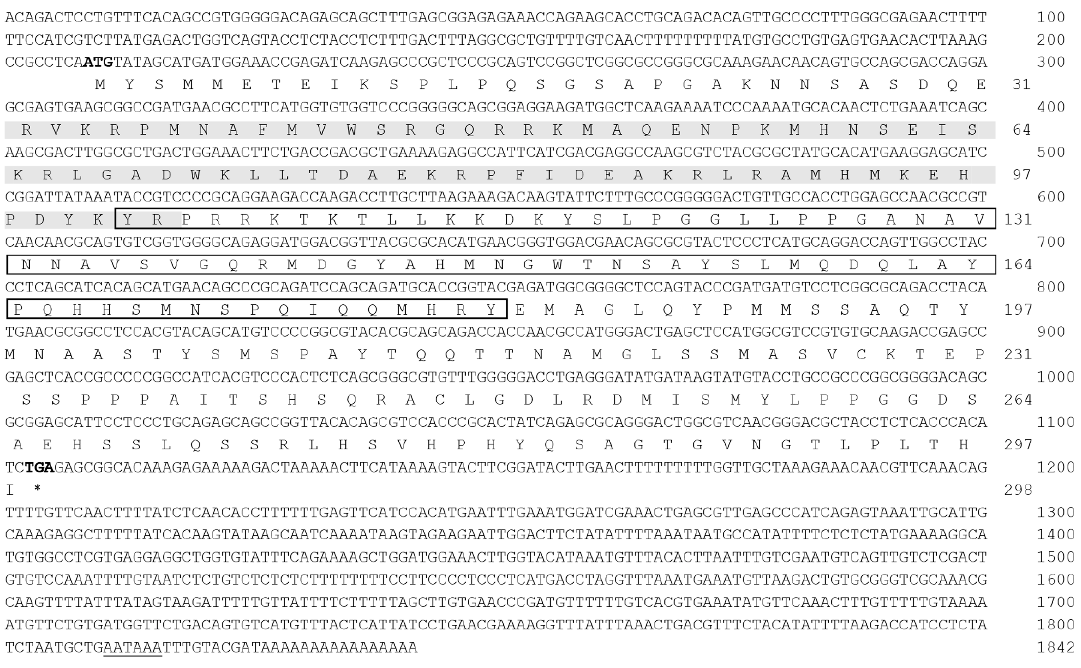
Figure 1. The nucleotide and deduced amino acid sequences of Posox3 . The HMG (high mobility group) box domain is shaded in gray and the SOXp (SOX transcription factor) domain is boxed. The start and stop codons are bold-typed and the stop codon is represented as asterisk (*). The polyadenylation signal (AATAAA) is indicated with single line. Nucleotides and amino acids are numbered at the right end of the lines.